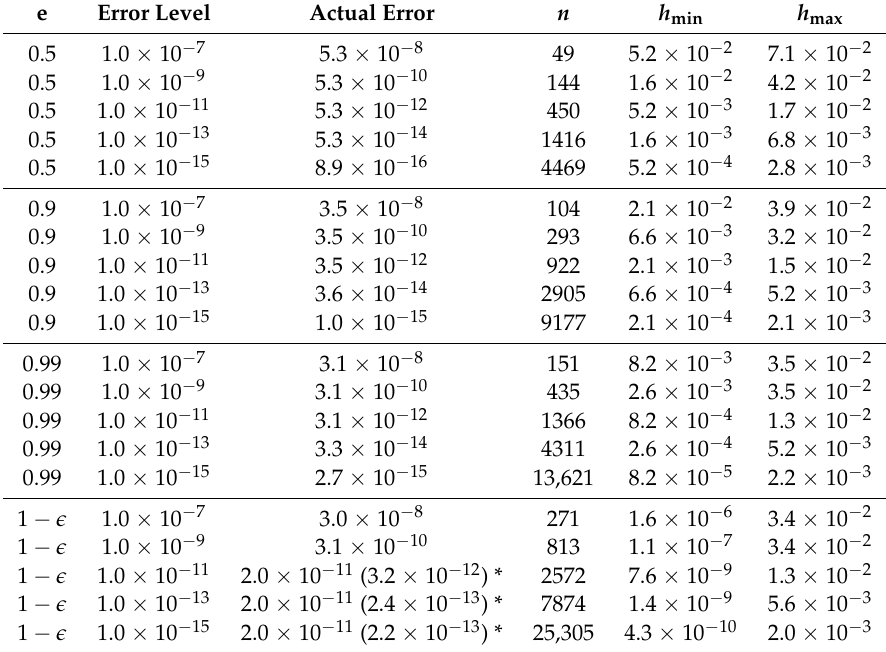
Table 1. Results are shown for the multistep routine with four different values of the eccentricity e and input error level. The actual error attained is given along with the number of grid intervals n , and the minimum and maximum steps h min and h max that are computed in the setup of the multistep routines. The star * for the actual error in the parenthesis in the limiting case e = 1 apply for y (cid:38) 10 − 9 rad. (The errors and the grid intervals are given in